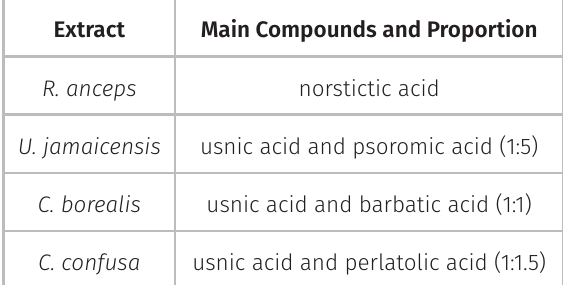
Table IV. Porportion of main compounds found in selected lichen extracts by NMR